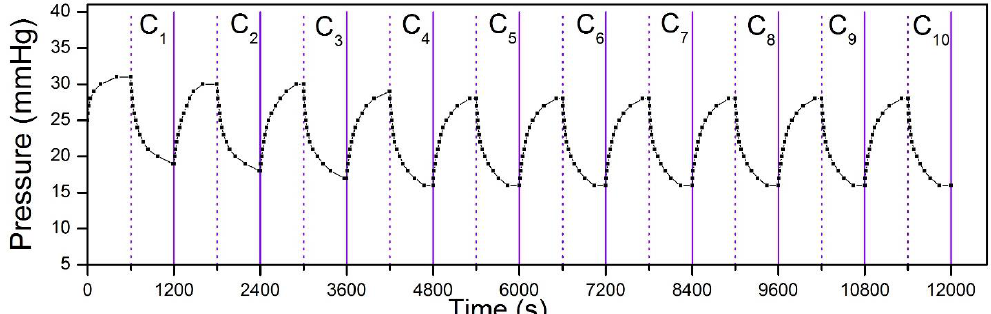
Figure 5. Result of extra pressure Δ P : ( a ) by changing temperature; ( b ) by changing strain; ( c ) by changing number of wrapping layers; and ( d ) by changing cylinder circumference.